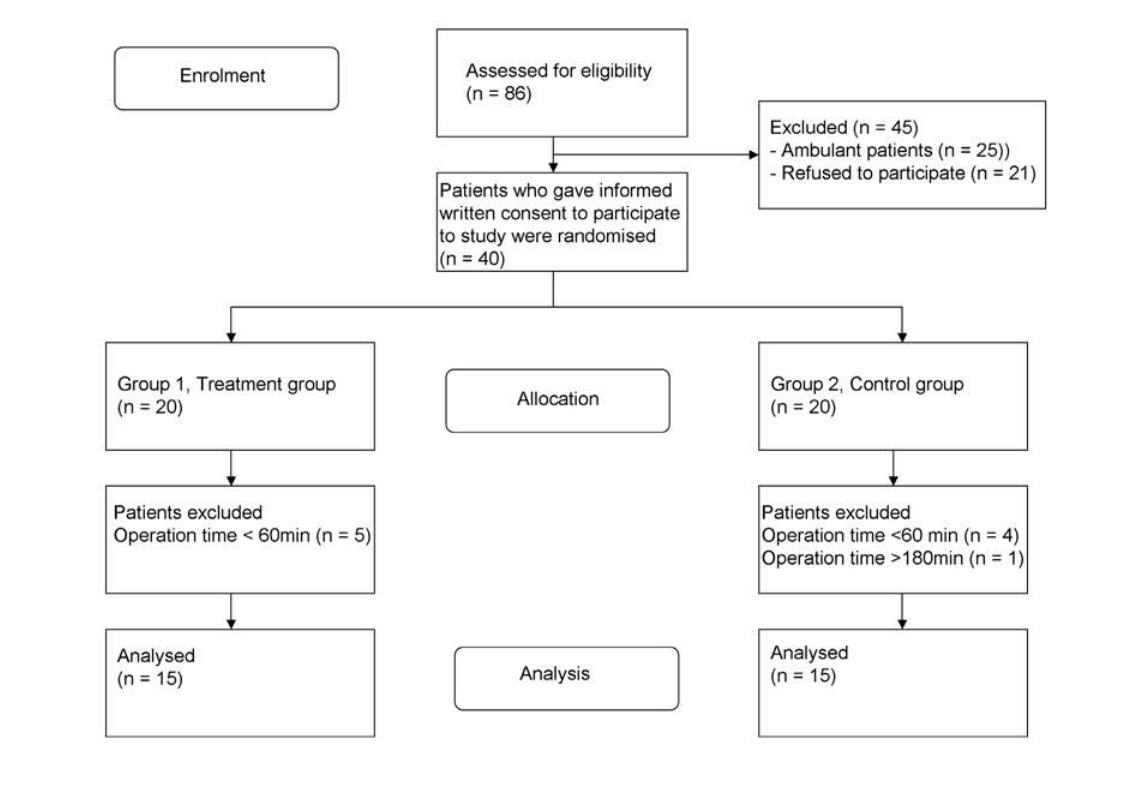
Figure 1 Flow diagram of the